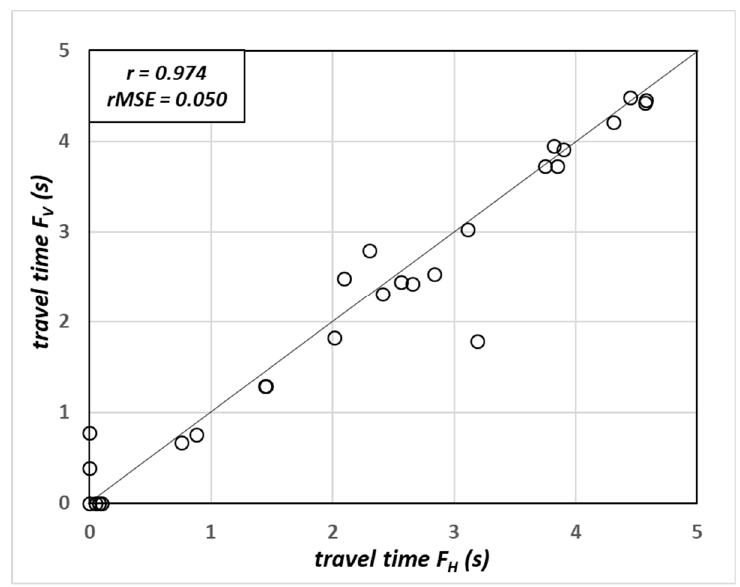
Figure 16. Comparison between the travel time of horizontal and vertical force events corresponding to the same test.